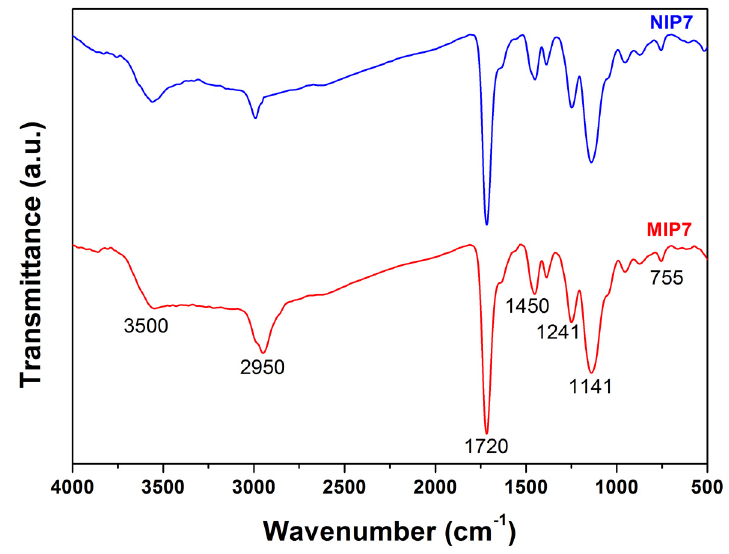
Figure 1. FT-IR spectra of MIP7 and NIP7.